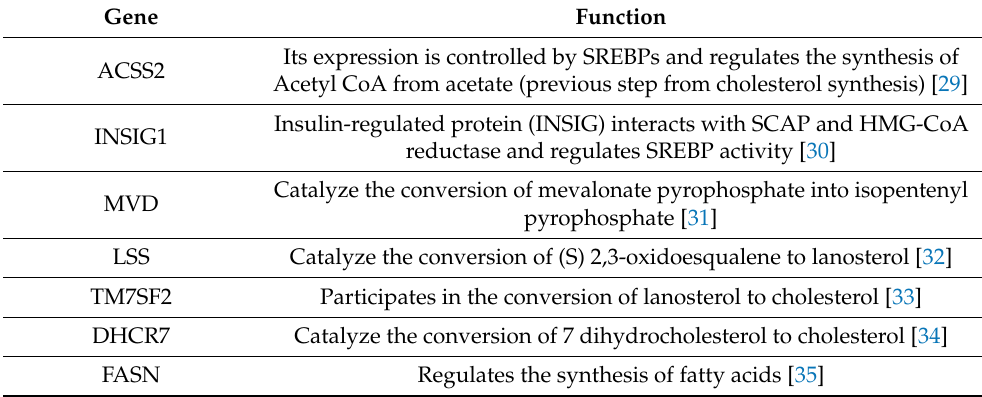
Table 1. Genes involved in the hepatic-steatosis induced by olanzapine and the protective effect of Maqui anthocyanins in HepG2